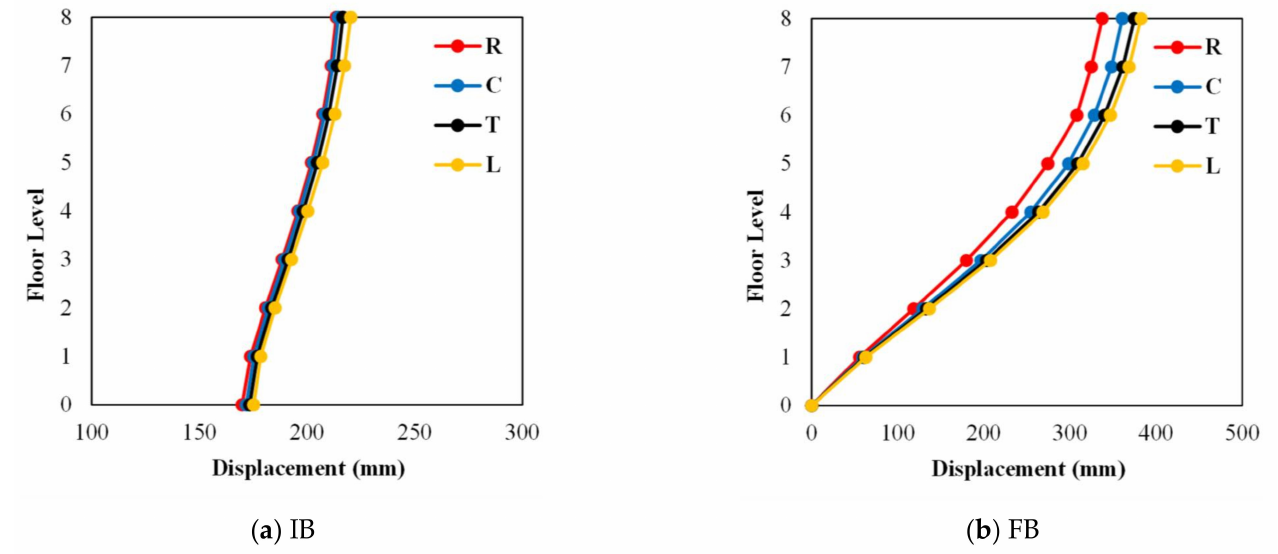
Figure 11. Floor displacements for isolated- and fixed-base R, C, T, and L models.